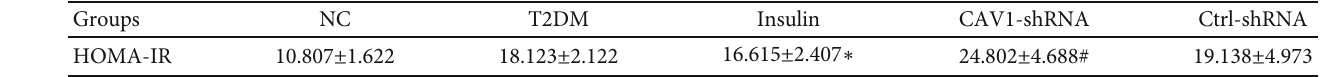
Table 1: HOMA-IR of all groups at the end of the